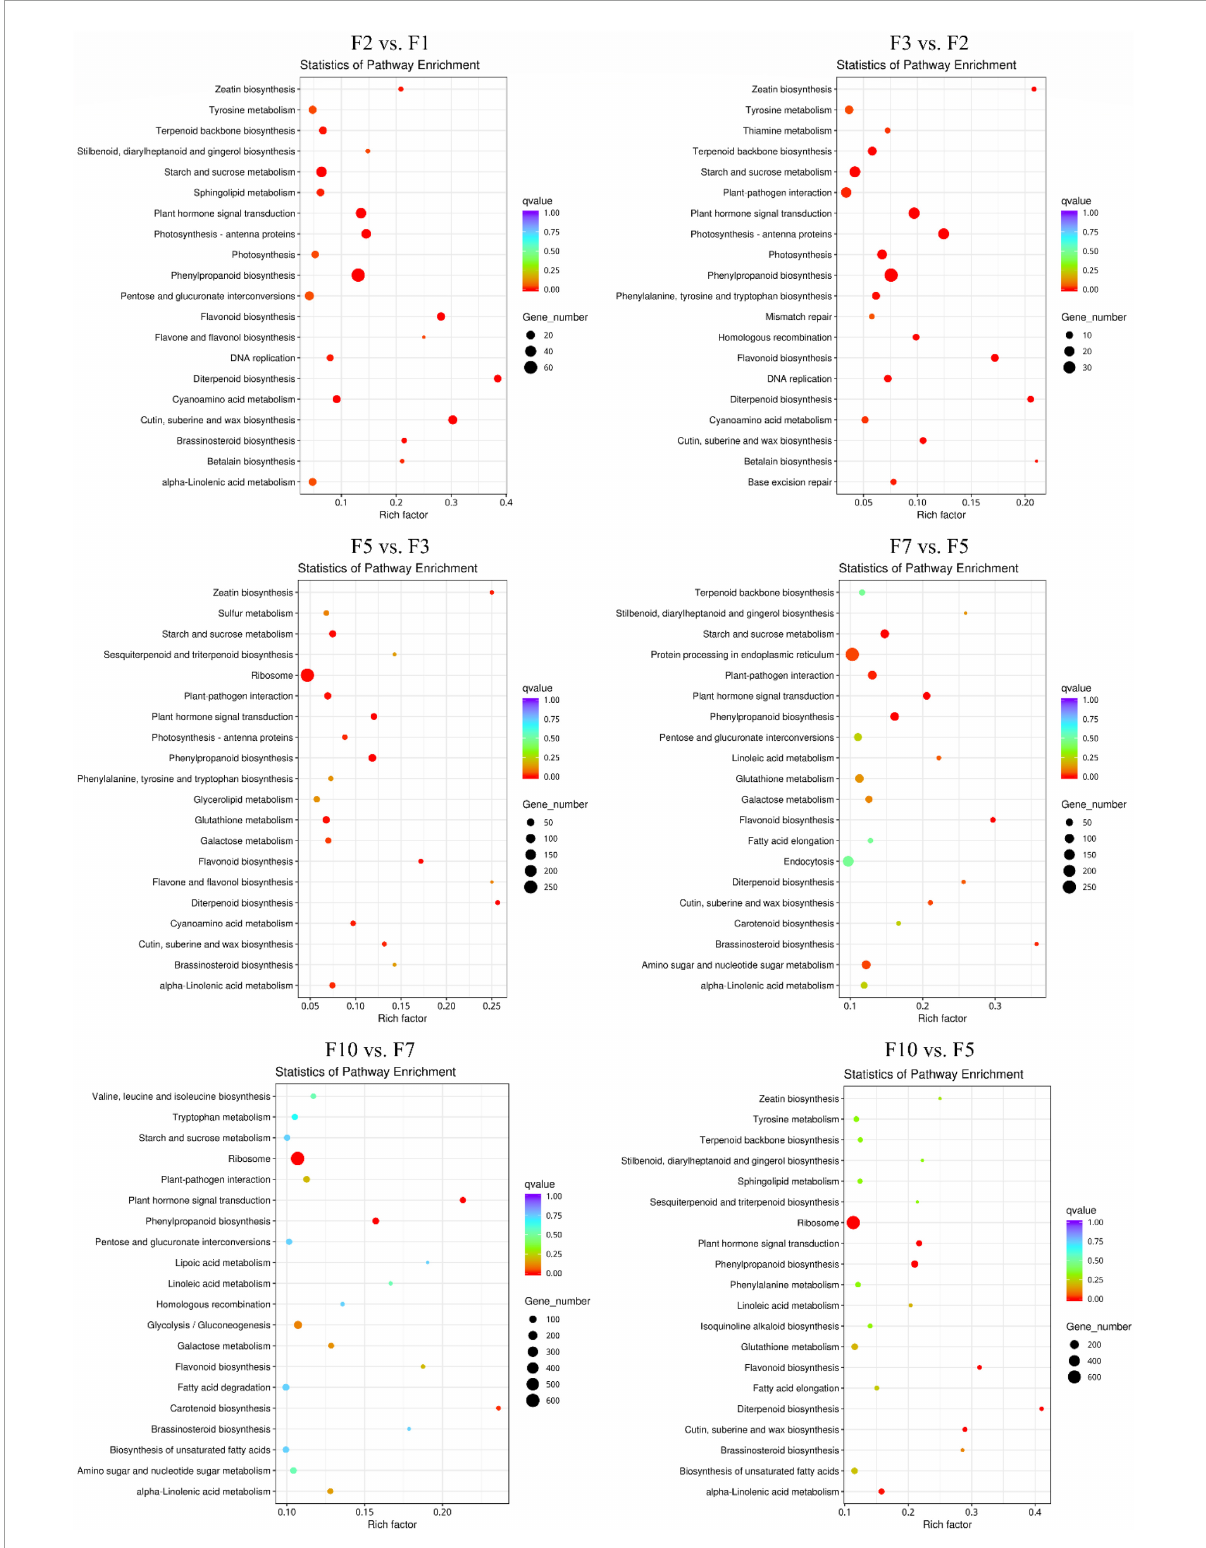
FIGURE7 Scatter diagram of the enriched Kyoto encyclopedia of genes and genomes (KEGG) pathways in Dacrydium pectinatum female cones. F, female cones. 1: January, 2: February, 3: March, 5: May, 7: July, 10: October.